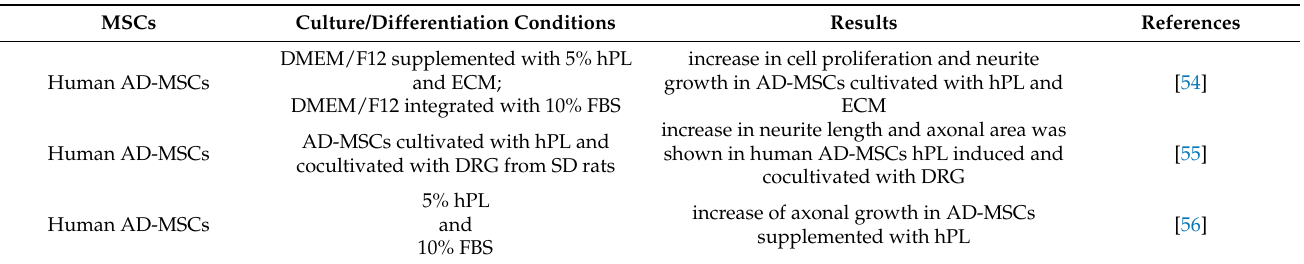
Table 3. Overview of the in vitro studies that summarize the effects of human platelet derivatives in MSC